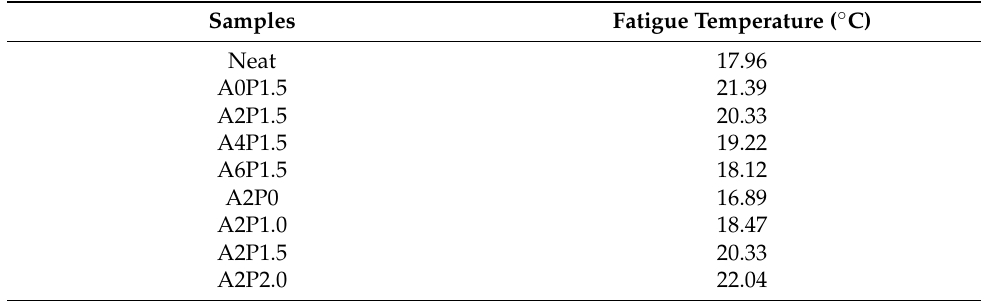
Table 8. Fatigue temperatures of all tested